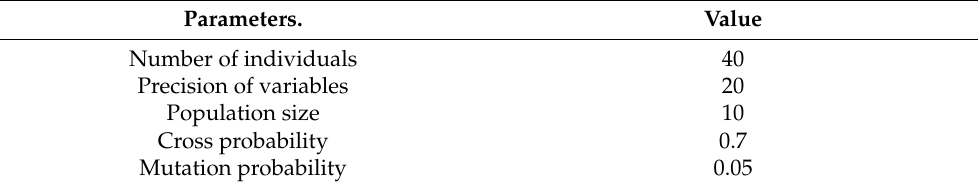
Table 5. The parameters of multi population genetic algorithm (MPGA).